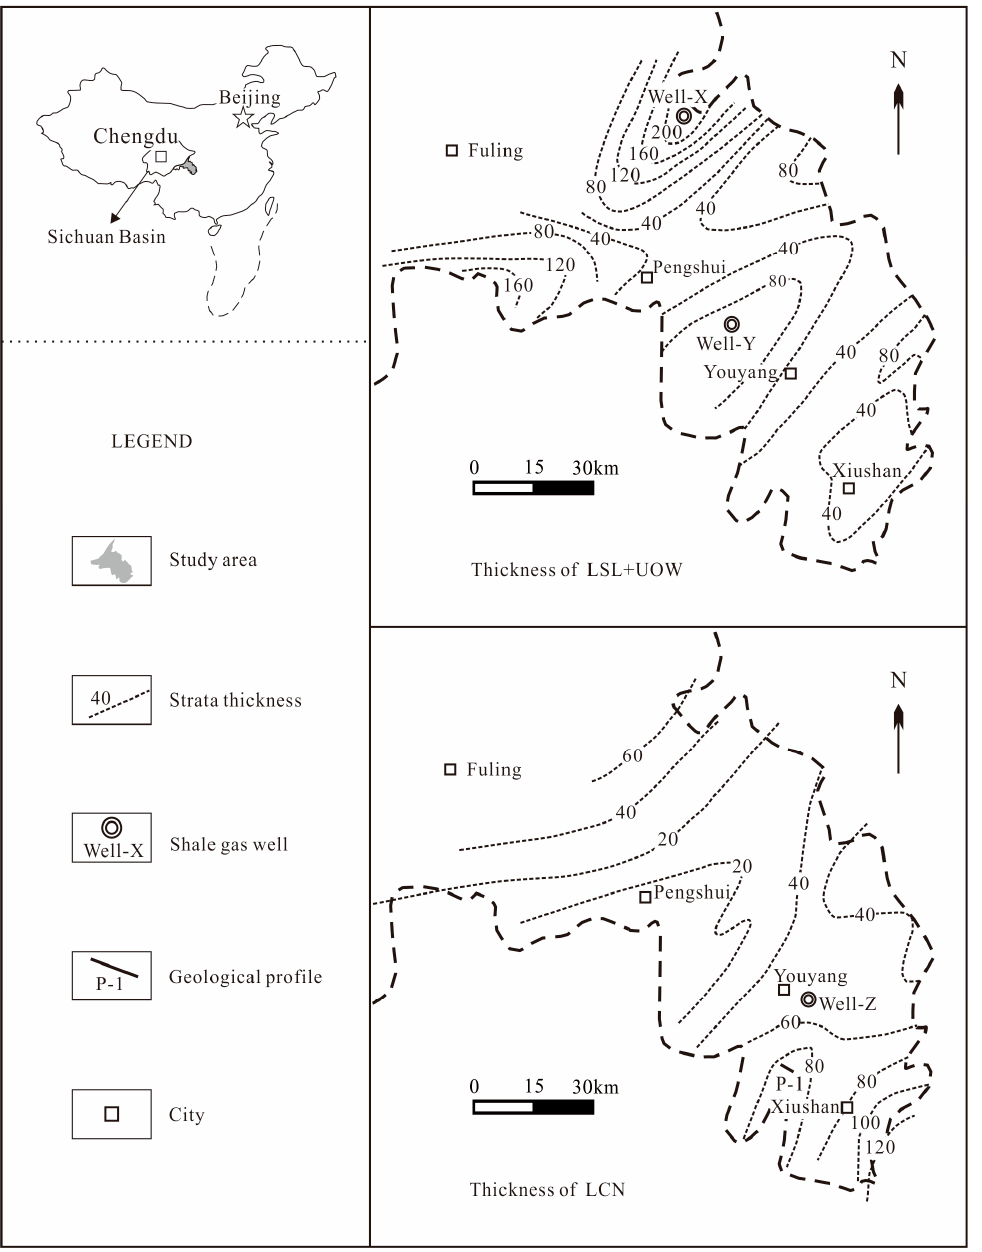
Figure 1. Regional overview of marine shales and sampling locations in the southeastern margin of the Sichuan Basin (modified from Liu et al. [10]).